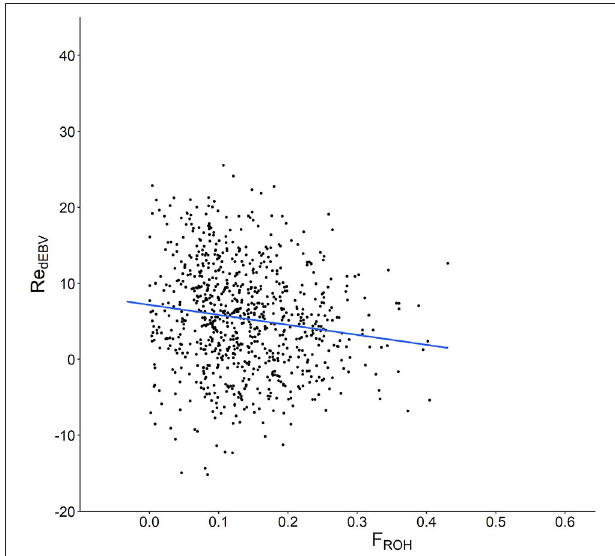
FIGURE 3 | Scatter plot showing the relationship between molecular homozygosity (F ROH ) in the x axis and the estimated breeding values for mare fertility (Re dEBV ) in the y